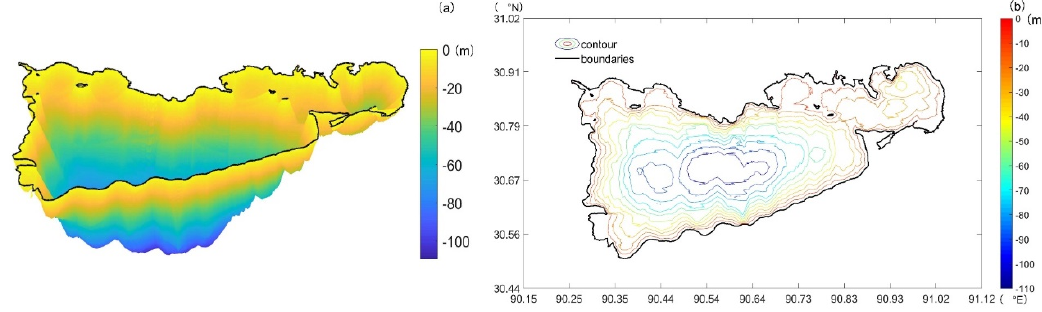
Figure 8. The modeling results of Lake Namco. ( a ) 3D map of the result using scaled model 1; ( b ) contour map of the result using scaled model 1.